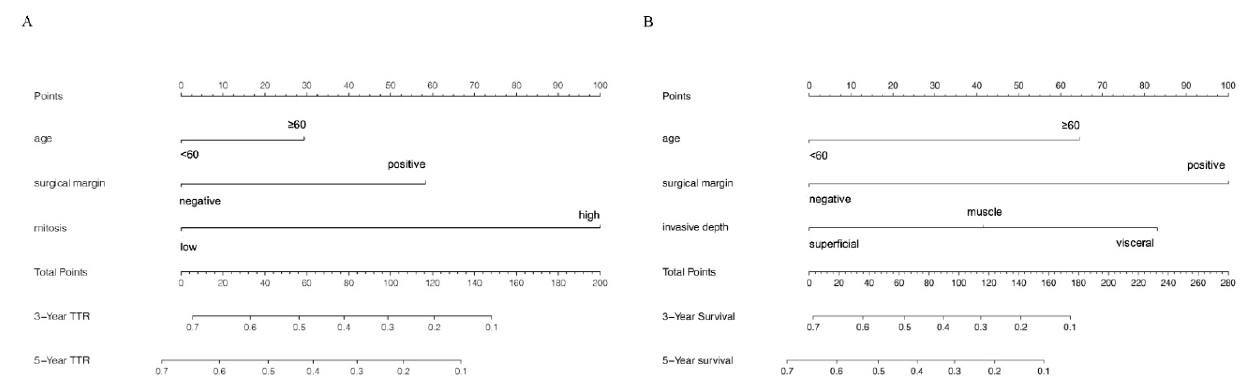
Figure 1. Nomograms for predicting 3- and 5-year ( A ) TTR and ( B ) OS for UPS patients who underwent primary surgery resections. Total points were calculated through addition of the scores of each clinicopathological feature mentioned above. The 3-year and 5-year possibility of recurrence ( A ) or survival ( B ) were obtained by drawing a vertical line from total points to 3-year and 5-year TTR or OS.